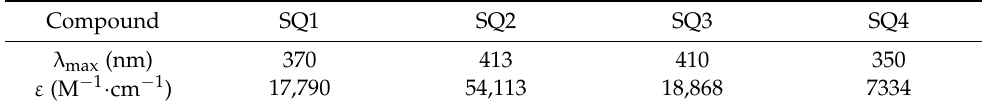
Table 12. Optical characteristics of SQ1–SQ4 in chloroform.